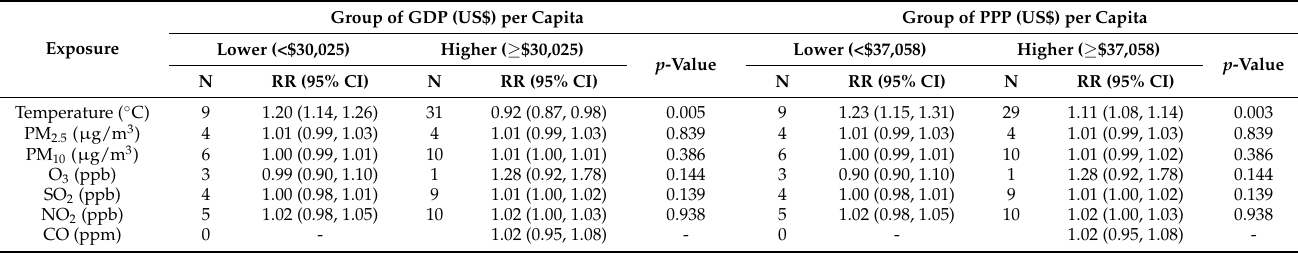
Table 5. Relative risks (RRs) and 95% CIs of suicide associated with an interquartile range (IQR) increase in temperature, PM 2.5 , PM 10 , and O 3 by GDP per capita and PPP per capita (US$).